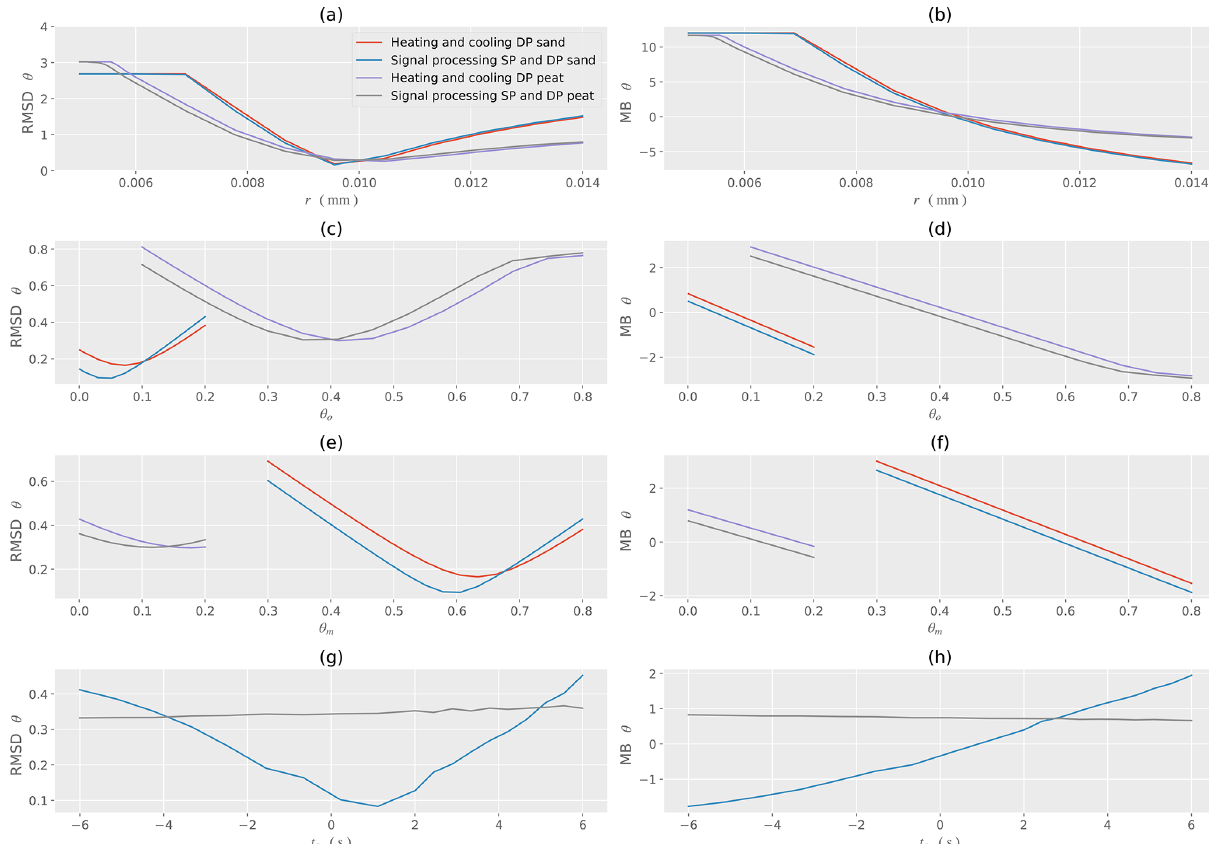
Figure 9. Sensitivity analysis for water content θ w for sand and peat with respect to the different models. (a) RMSD for changes in the calibrated initial radius r . (b) MB for changes in the calibrated initial radius. (c) RMSD for changes in the organic volume fraction θ o . (d) MB for changes in the organic volume fraction θ o . (e) RMSD for changes in the mineral volume fraction θ m . (f) MB for changes in the mineral volume fraction θ m . (g) RMSD for changes in the time delay t a . (h) MB for changes in the time delay t a